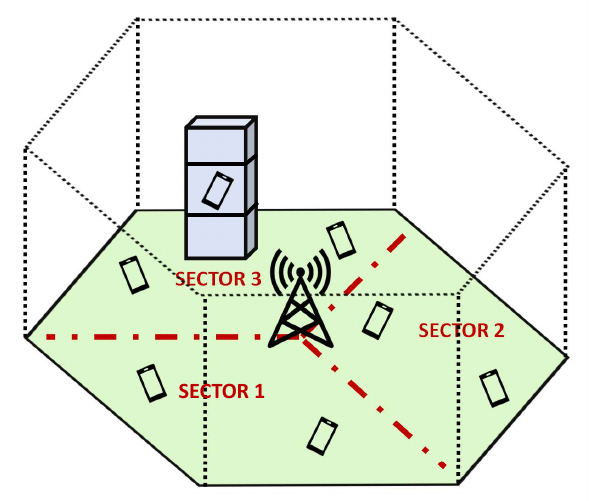
Figure 1. Hexagonal cell site divided into three sectors.